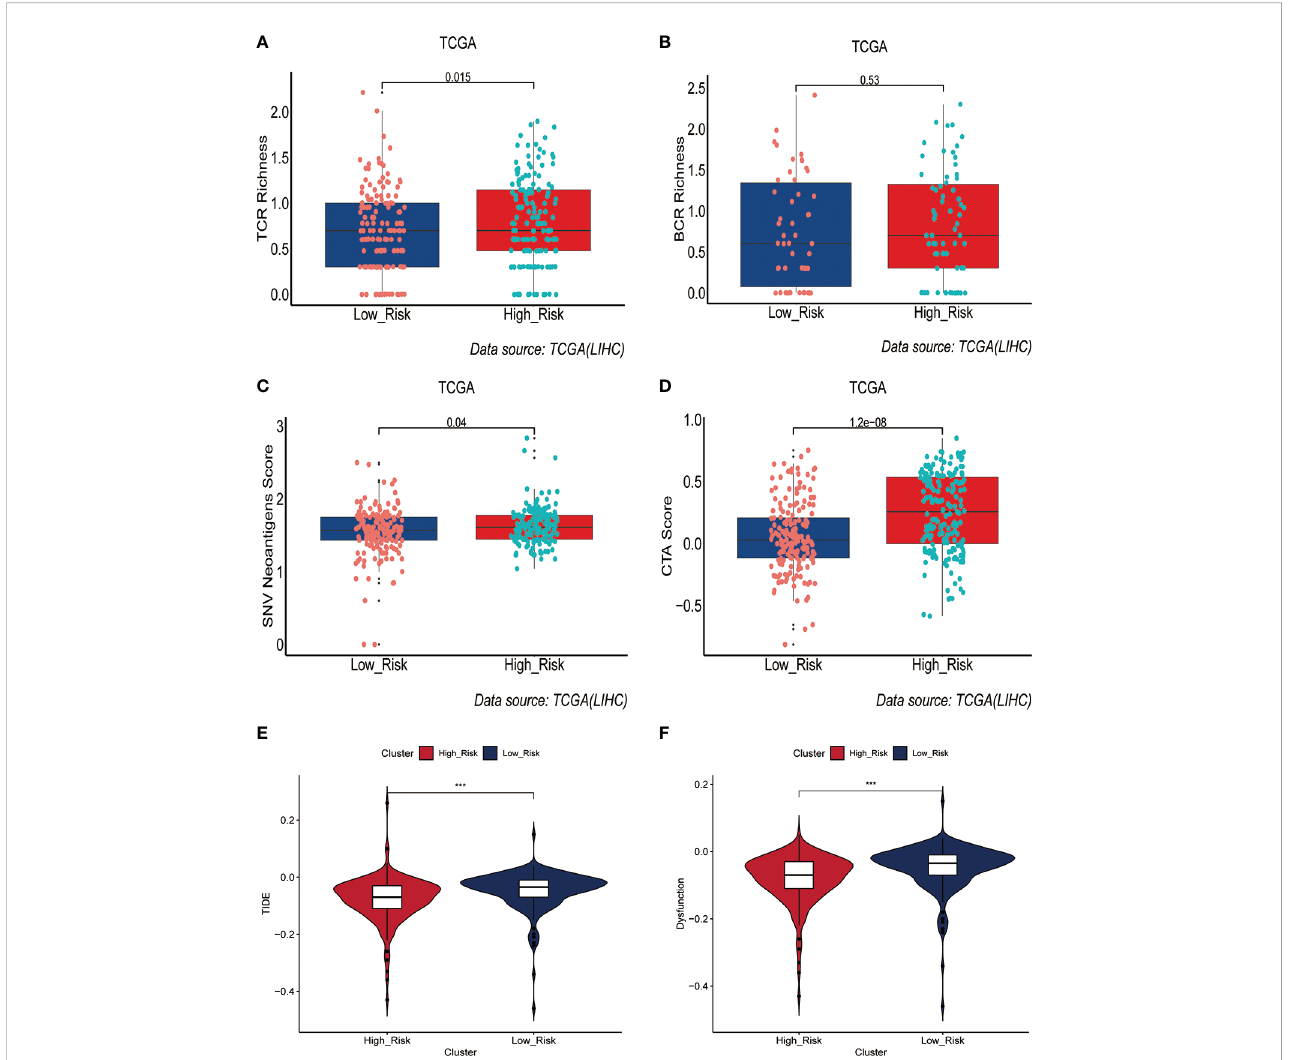
FIGURE 8 Prediction of immunotherapy response by prognostic signature in the training set. (A-D) Differences in TCR richness (A) , BCR richness (B) , SNV Neoantigens (C) and CTA scores (D) between the high-risk and low-risk groups. (E-F) TIDE scores (E) and Dysfunction scores (F) were used to assess immunotherapy